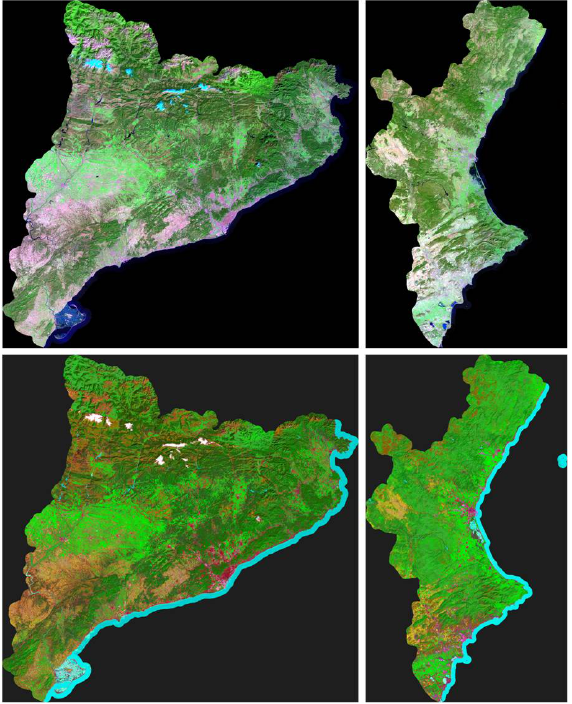
Figure 5. Land covers classification result by applying Minimum Distance